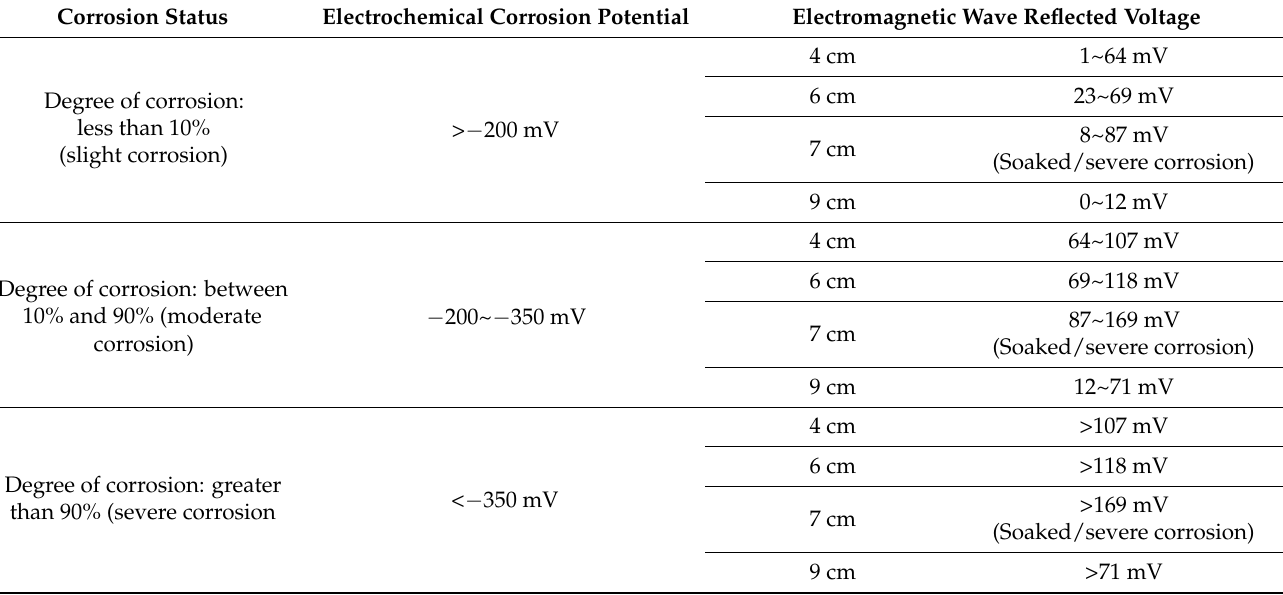
Table 2. Comparison of the Degree of Corrosion by Potential and